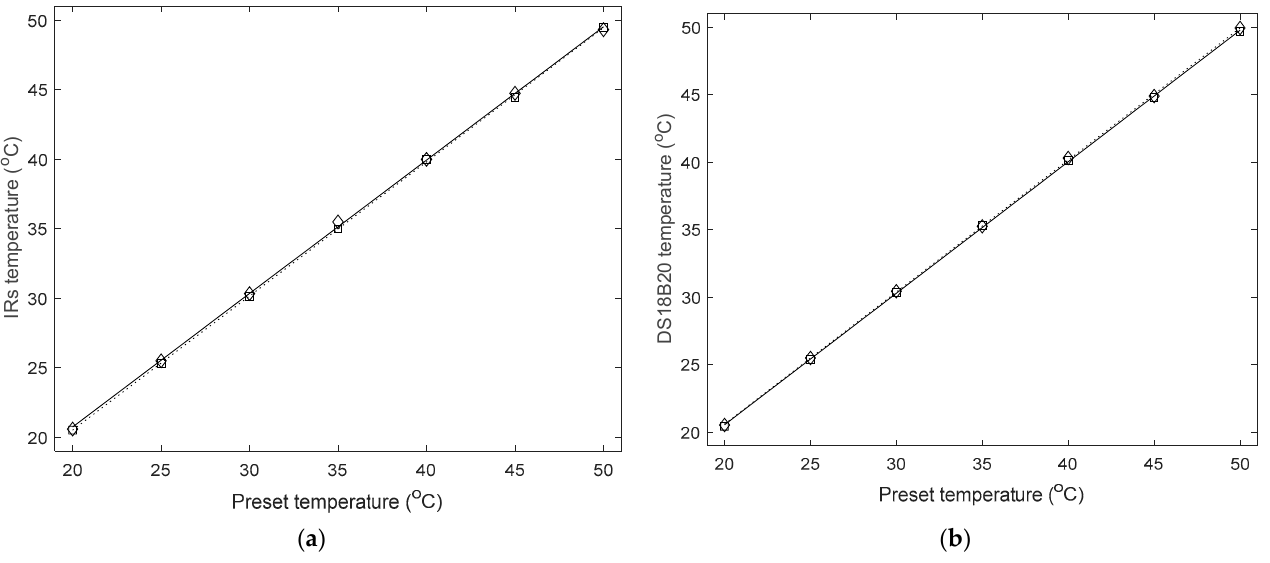
Figure 2. Sensor performance evaluation: ( a ) IRs and ( b ) DCTM sensor (DS18B20). Diamonds “ ◇ ” represent the increasing values and squares “ □ ” represent the decreasing values. In addition, the dotted line indicates the trend for the temperature increasing test, while the solid line shows the trend for the temperature decreasing test. The equation of IRs for temperature increase was y = 0.957x + 1.628 whereas that for temperature decrease was y = 0.966x + 1.181. In comparison, the equation of the DCTM sensor for temperature increase was y = 0.965x + 1.218 whereas that for temperature decrease was y = 0.959x + 1.555 .